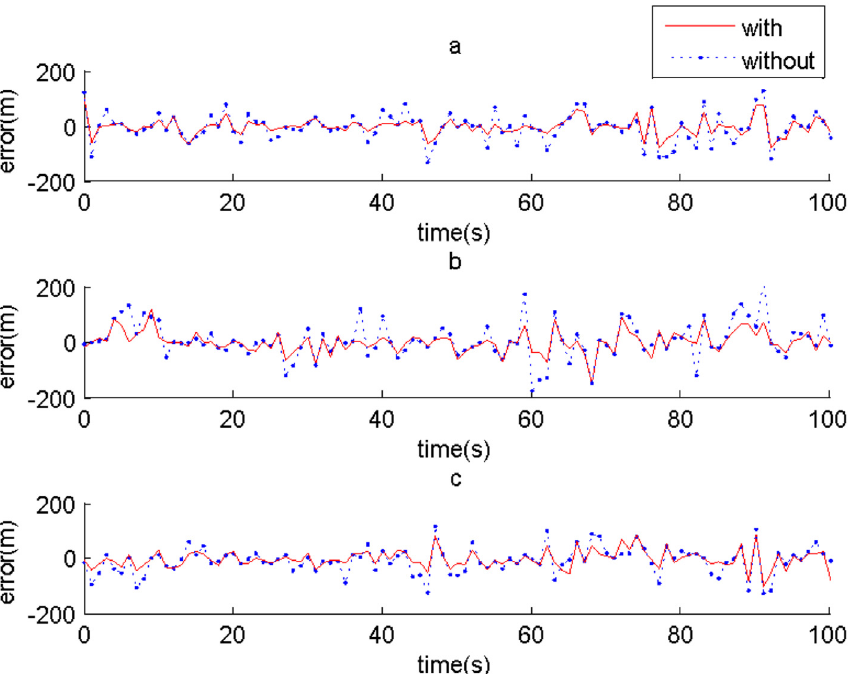
Fig 3. Comparisons of error between the cases with reliability analysis and without reliability analysis of target1. (a) In x-axis, (b) In y-axis, and (c) In z-axis.